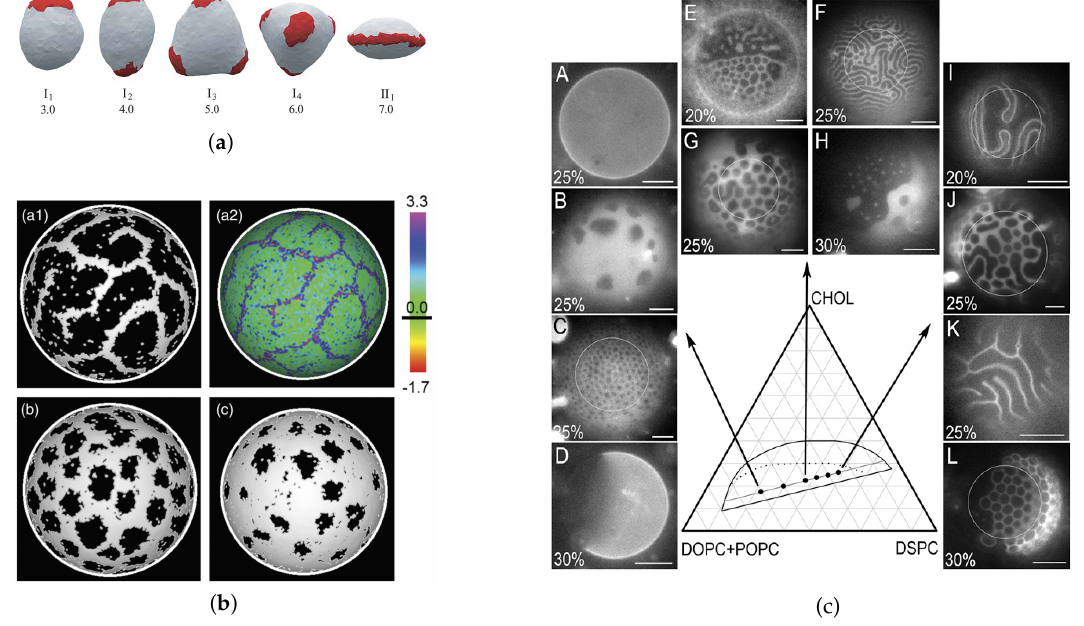
FIGURE 2 Modulated phase patterns are observed along tieline 1 at 20% % r % 30%. The r -value for each GUV is noted in each image. Images were contrast enhanced and cropped. Composite images of two focused slices contain a white ring marking the boundary of the composite Figure 5. ( a ) Numerical model of biphasic vesicle with Lo (in white) and Ld (in red) separated image. For reference, the upper Ld Lo boundary is shown for r 0% þ ¼ ( dotted ) and r 100% ( solid ); both r slices share a common lower phases, sampled by Monte Carlo simulations. The ratio κ Lo / κ Ld is indicated below each vesicle. Most ¼ boundary( solid )(T.M.Konyakhinaetal.,unpublished).GUVcompositions curvature is accumulated in the more flexible Ld phase. Reproduced from [53], with permission DSPC/(DOPC POPC)/CHOL: ( A–D ) 0.225/0.60/0.175 (T1F), ( E–H ) þ 0.375/0.40/0.225 (T1D), ( I–L ) 0.487/0.25/0.263 (T1A). The dye C12:0- from The Royal Society of Chemistry, Copyright 2011. ( b ) Another numerical modeling of a biphasic vesicle with various Lo and Ld area fractions (Lo is black and Ld is white), showing patterned morphologies. Panel ( a2 ) is the same simulation snapshot as panel ( a1 ), but displays the mean curvature map instead (curvature units in the color scale on the right are in µ m − 1 ), thus illustrating the coupling between the local composition and curvature. The most flexible Ld phase is also the most bent one. Reproduced from reference [123], with permission from the American Physical Society, Copyright 2013. In both panels ( a , b ), the spontaneous curvature C sp has been set to 0 for both phases. ( c ) Fluorescence microscopy images showing a large variety of patterns in the 4-component 1,2-distearoyl-sn-glycero-3-phosphocholine(DSPC)/1,2-Dioleoyl-sn-glycero-3-phosphocholine (DOPC)/1-palmitoyl-2-oleoyl-sn-glycero-3-phosphocholine (POPC)/cholesterol vesicles, displaying coexistence of Lo (dark grey) and Ld (light gray) phases below the demixing temperature T d . The vesicles either appear homogeneous or display roundish domains or labyrinthine phases according TABLE 1 Compositions examined in modulated phase to the concentrations of the different lipids. The percentage indicated in each panel is the DOPC to window studies DOPC+POPC molar ratio ρ . Scale bars: 10 µ m. Temperature: 23 ◦ C. Reproduced from [49], Composition